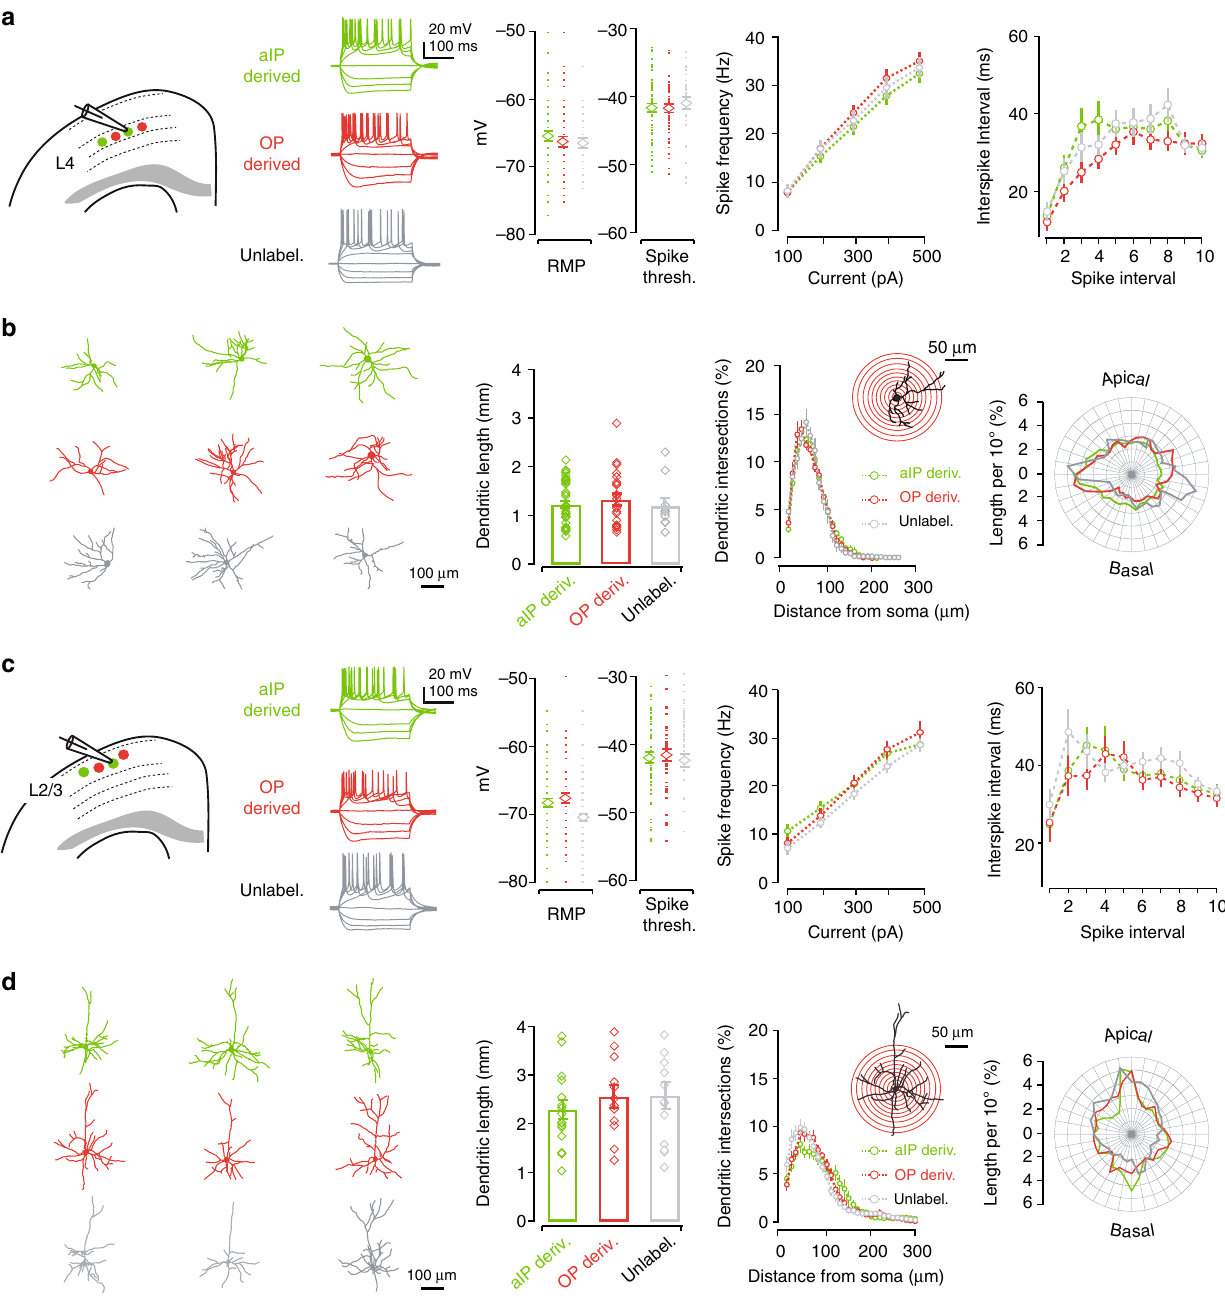
Fig. 3 Neuronal excitability and morphology do not differ by progenitor pool. a aIP- and OP-derived L4 neurons exhibited comparable intrinsic membrane properties, including resting membrane potential (RMP; p = 0.26), spike threshold ( p = 0.52) and spiking patterns to injected current (spike frequency: p = 0.27; 1st interspike interval: p = 0.22, Mann – Whitney U test in each case). b Anatomical reconstruction of aIP- and OP-derived L4 spiny stellate neurons revealed comparable dendritic lengths, dendritic complexity as assessed by Scholl analysis, and dendritic polarity ( p = 0.28, p = 0.74, and p = 0.51, ANOVA). c Within L2/3, aIP- and OP-derived neurons exhibited comparable membrane properties, including RMP ( p = 0.89), spike threshold ( p = 0.49), and spiking patterns to injected current (spike frequency: p = 0.66; 1st interspike interval: p = 0.65, Mann – Whitney U test in each case). d aIP- and OP- derived L2/3 neurons exhibited pyramidal morphologies with comparable dendritic lengths, complexity, and polarity ( p = 0.39, p = 0.82, and p = 0.99, ANOVA). Error bars represent standard error of the mean. Source data are provided as a Source Data fi le L5 represents the main cortical output layer and its sublayers numerous subcortical targets including thalamus, basal ganglia, route excitatory synaptic information to different downstream brainstem sites, and spinal cord 41 – 43 . Using an optogenetic strategy, we expressed ChR2 in either aIP-derived neurons or OP- circuits 40 . L5a pyramidal neurons lie more dorsally within L5 and are associated with the direct routing of excitatory synaptic derived neurons by IUE of either a Cre-ON or Cre-OFF ChR2 information to other regions of cortex. Meanwhile L5b pyramidal plasmid (see Methods 44 , in combination with the T α 1-Cre plas- mid (Fig. 6a). This enabled us to selectively activate axons from neurons lie more ventrally and have projections that innervate NATURE COMMUNICATIONS| (2019) 10:5224